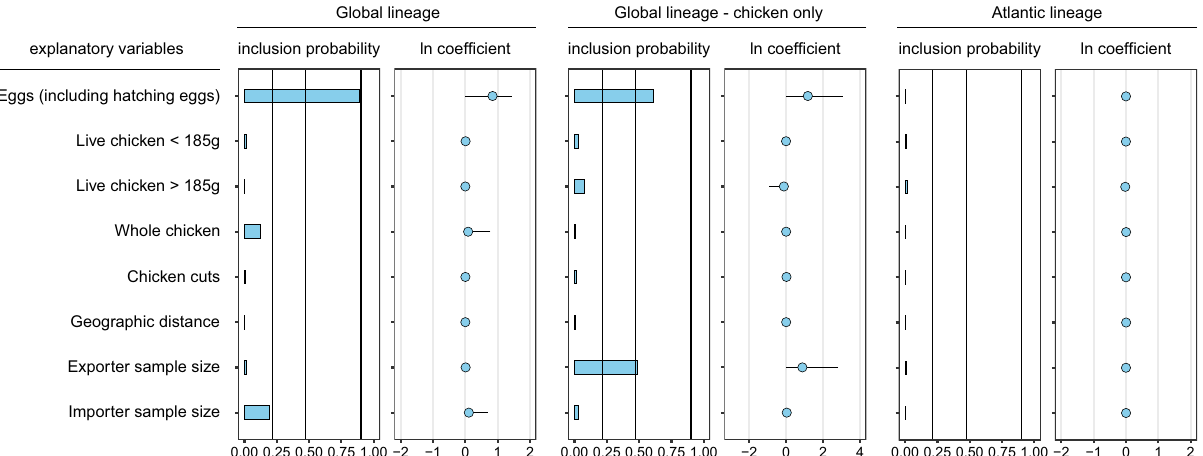
Fig. 7 Contributions of explanatory variables to the international spread of Salmonella Enteritidis in the Global and the Atlantic lineages. Inclusion probabilities corresponding to Bayes factor support values of 3, 10, and 100 are represented by vertical lines in the bar plots, respectively. The conditional effect size (ln coef fi cient), which is the effect size when the variable is included in the model, is represented by the mean and credible intervals (95% HPD intervals) of the GLM coef fi cients on a log scale. HPD, highest posterior density. Bars show the posterior probability of inclusion of each variable in the GLM model. Circles show the estimated conditional effect sizes for the GLM coef fi cients (>0 = positive association, <0 = negative